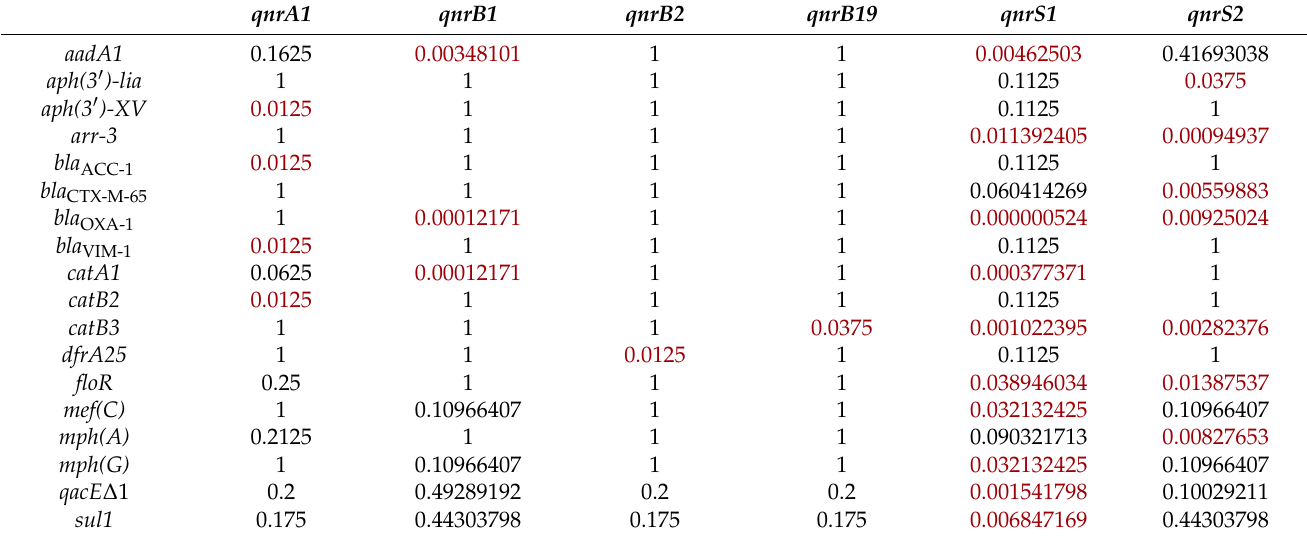
Table 3. p -value for co-occurrence of selected resistance genes and qnr genes in ESBL-monitoring isolates; p -values below 0.05 are highlighted in red and represent statistical significance. The value 1 reflects that the two genes were not